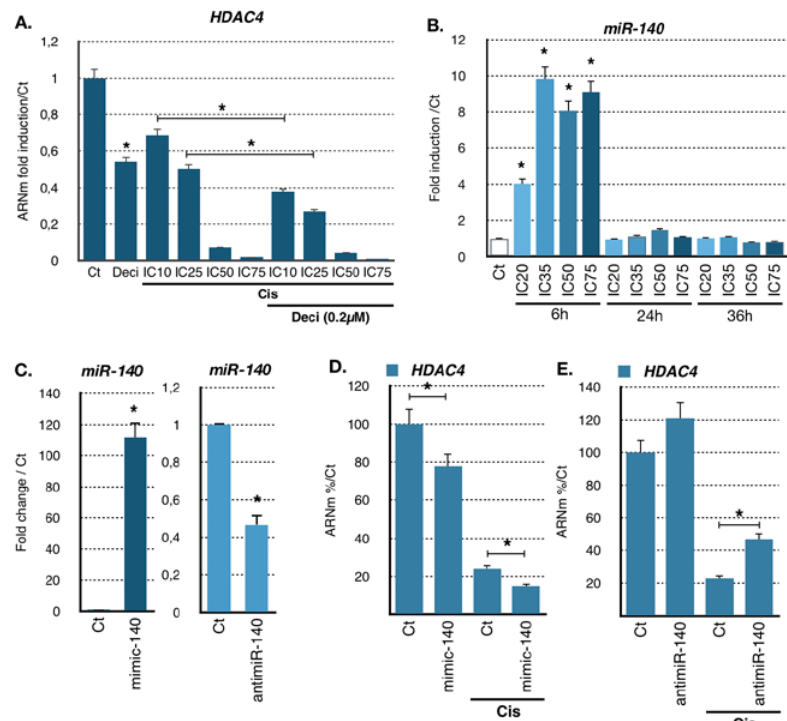
Figure 2. miR140-dependent regulation of HDAC4 expression in gastric cancer cells treated with cisplatin. ( A ) Expression of HDAC4 in the AGS cell line treated with cisplatin and decitabine. HDAC4 mRNA level in AGS cells treated for 24 h was assayed by RT-qPCR. Bars are means of fold induction versus the control (Ct). *, p < 0.001 ( n = 3), compared with the control, calculated by one-way ANOVA followed by a Tukey post-test. ( B ) Expression of miR-140 in AGS cells treated with cisplatin over time at increasing concentrations. miRs levels were assayed by RT-qPCR. Bars are means of fold induction versus the control (Ct) and the indicated cisplatin concentrations. *, p < 0.001 ( n = 3), compared with the control, as calculated by one-way ANOVA followed by a Tukey post-test. ( C ) Expression of miR-140 in AGS cells transfected 48 h with a miR-140 specific mimic (mimic-140; 100 nM) or antimiR (antimiR-140; 30 nM) specific for miR-140 and treated or not with cisplatin (25 µ M, 12 h). MiR-140 was assayed by RT-qPCR. Bars are means of fold induction versus the control (Ct). *, p < 0.001 ( n = 3), compared with the control mimic, and the control antimiR, as calculated by one-way ANOVA followed by a Tukey post-test. ( D , E ) Expression of HDAC4 in AGS cells transfected 48 h with a miR-140 specific mimic (D. mimic-140; 100 nM) or antimiR (E. antimiR-140; 30 nM) specific for miR-140 and treated or not with cisplatin (25 µ M, 12 h). HDAC4 RNA level was assayed by RT-qPCR. Bars are means of fold induction versus the control (Ct). *, p < 0.001 ( n = 3), compared with the control mimic, and the control antimiR, as calculated by one-way ANOVA followed by a Tukey